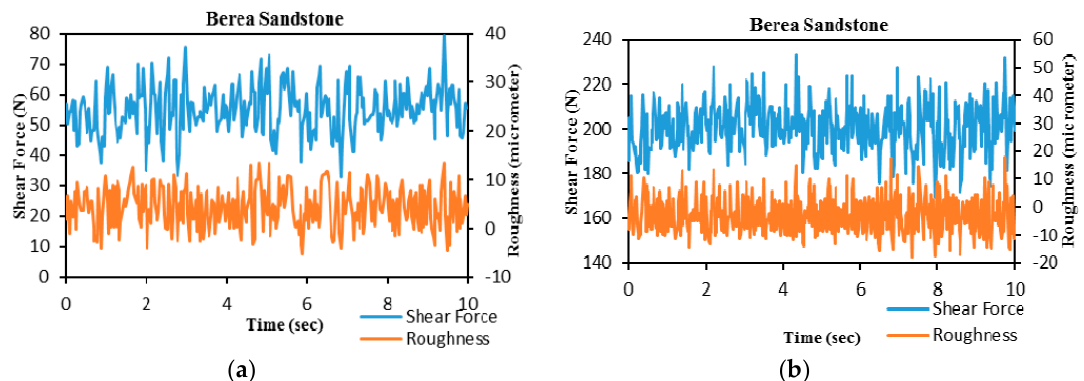
Figure 10. Scratch test results for a Berea Sandstone sample at different DOCs: ( a ) d = 0.15 mm; ( b ) d = 0.2.